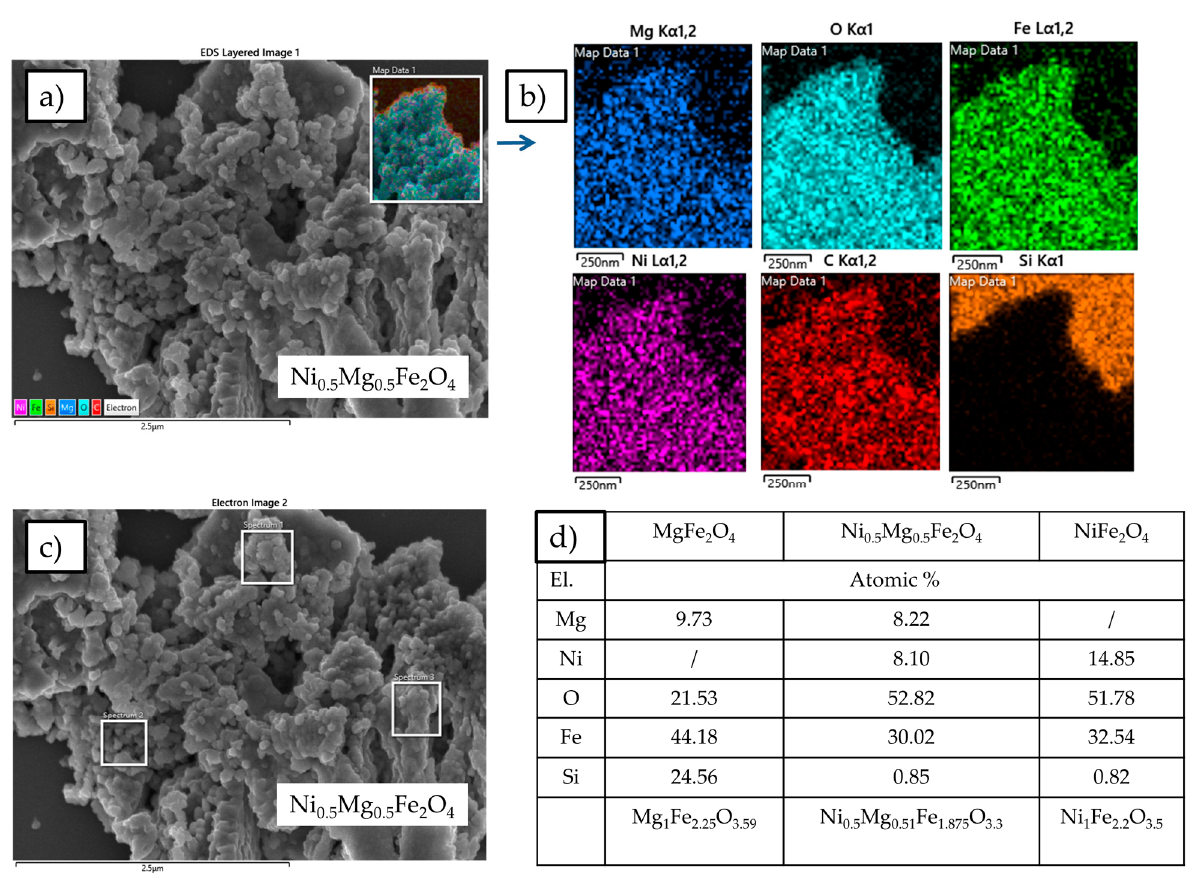
Figure 6. ( a ) SEM micrograph collected on Ni 0.5 Mg 0.5 Fe 2 O 4 ; ( b ) Elemental mapping of Mg 0.5 Ni 0.5 Fe 2 O 4 inferred from Energy dispersive spectrometry (EDX) coupled to SEM; ( c ) Selected